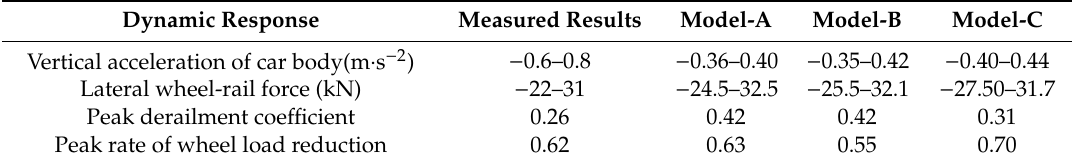
Table 3. Comparison between measured data and simulation. Figure 9. Comparison between the results of Model-C and [24].